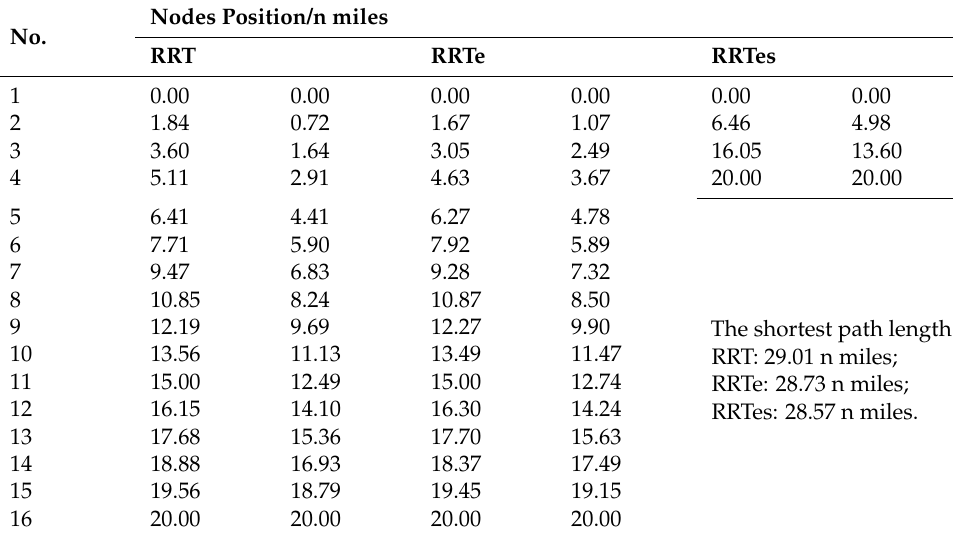
Figure 10. The relationship between the minimum water depth and navigable map. Table 1. The nodes position and shortest path length of three